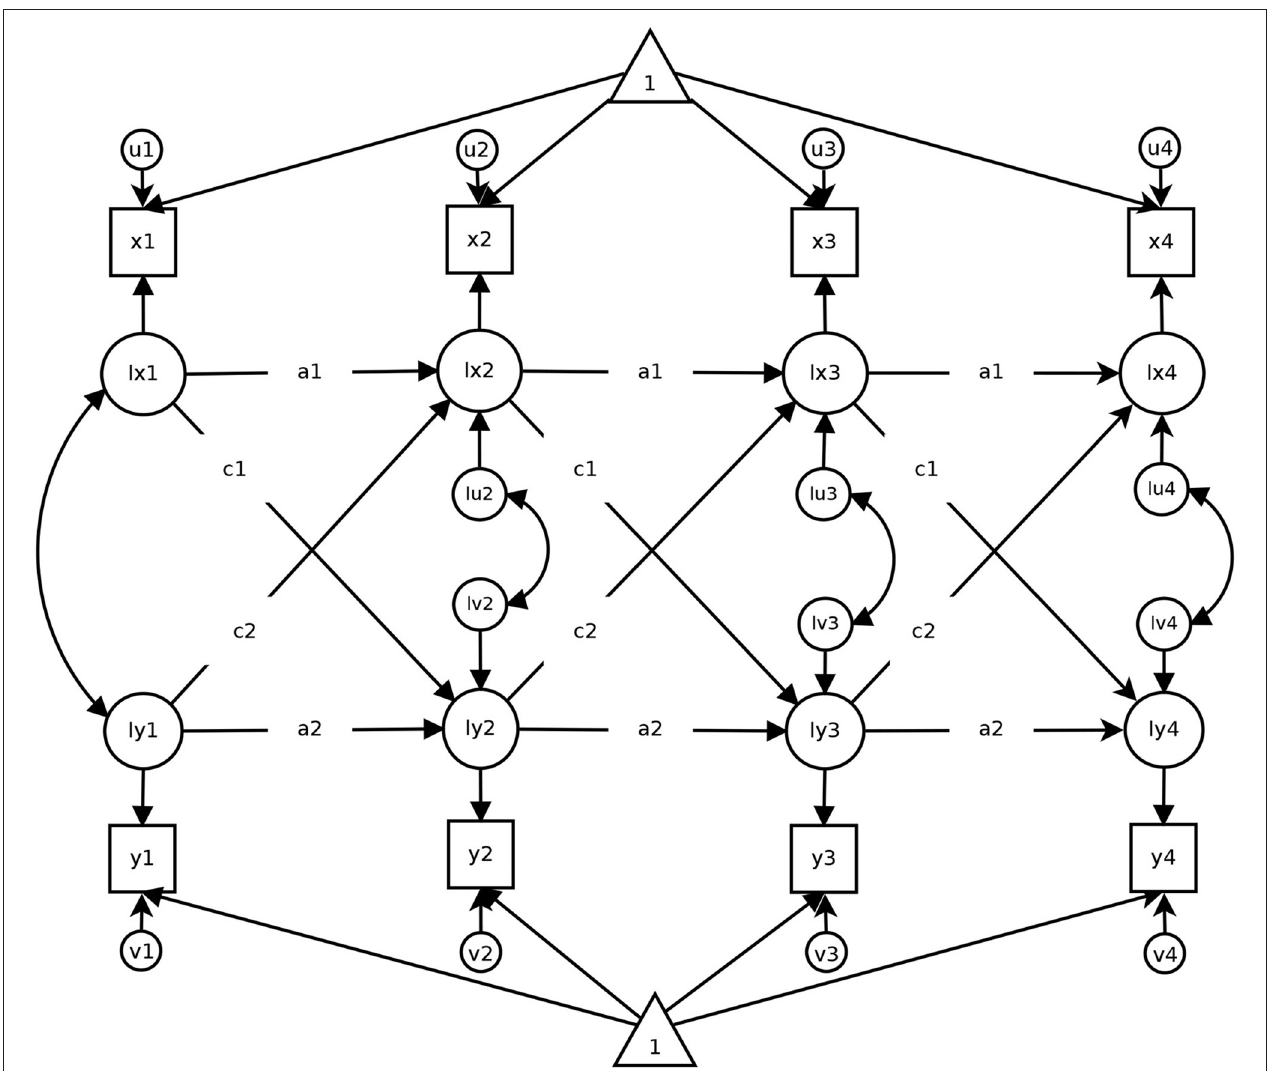
FIGURE 1 | A Cross-Lagged Panel Model with four measurement occasions. Squares represent observed variables (e.g., test scores), circles indicate latent variables. Triangles refer to intercepts. Directional arrows indicate regressions, double-headed arrows indicate correlations. Equal path labels (e.g., a 1) that the respective path was constrained to be equal across time. The figure has been published in Mund and Nestler (2019) under a CC-BY 4.0 license and is available at https://osf.io/sjph7/.